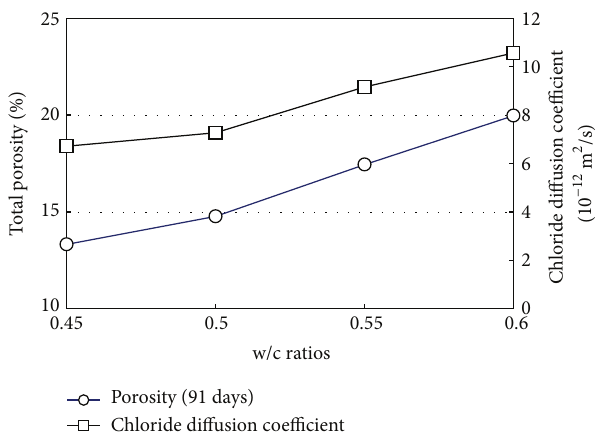
Figure 4: Chloride diffusion coefficient and porosity with different W/C